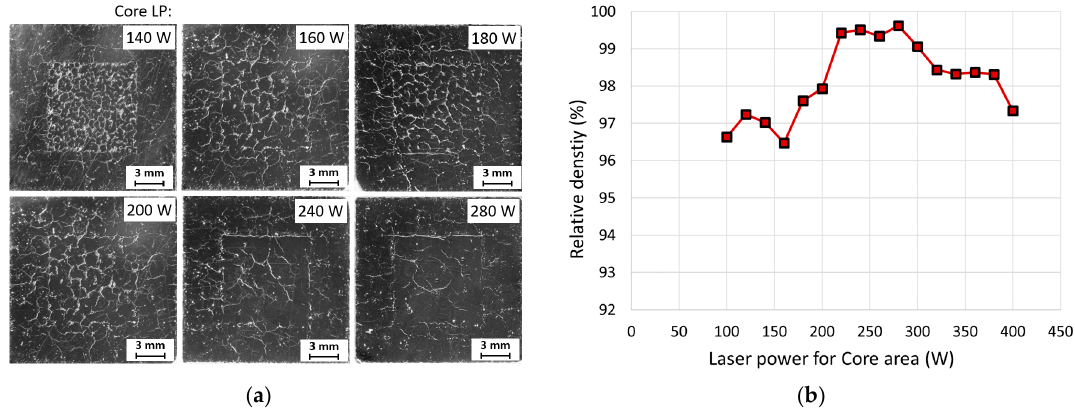
Figure 10. Defects in cube samples fabricated using the hull and core strategy; ( a ) metallography, top view of sample’s cross section; ( b ) dependence of relative density and laser power of the core area.